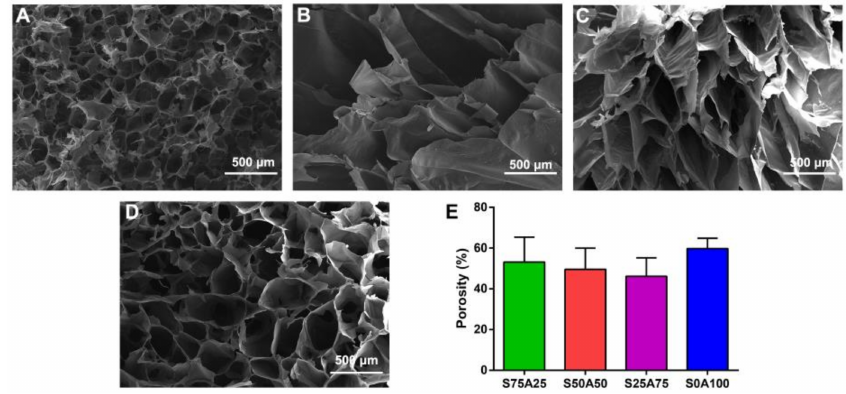
Figure 2. The porous microstructures of S75A25 ( A ), S50A50 ( B ), S25A75 ( C ), and S0A100 ( D ) gels. The porosity of gels with different ratios of sericin and agarose ( E